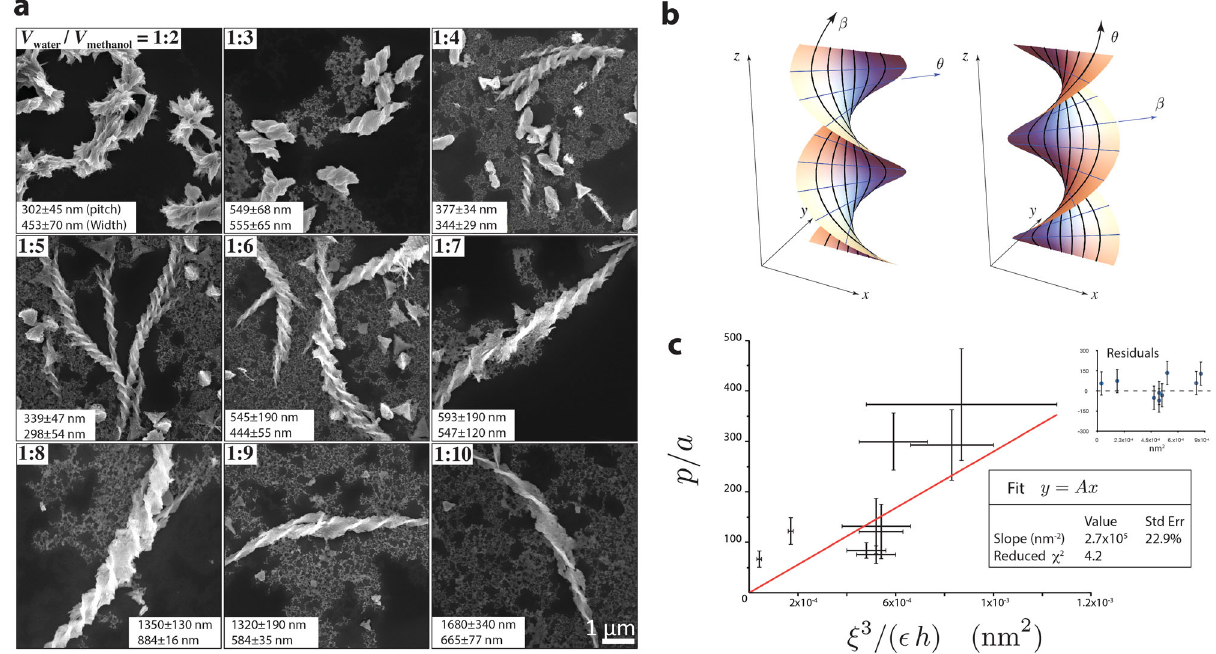
Fig. 3 Comparing morphology of assemblies from experiment and theory. a Experimental observation of helical assemblies of tetrahedral CdTe NPs. b Helicoidal solution for the ribbon ’ s mid-surface obtained from the model. c Linear prediction of the helicoid ’ s pitch on ξ , ϵ , h [Eq. (19)] (red line) fi tted on the experimental data (black data points), where a = 4.5 nm. Error bars show the upper and lower quartiles of the distribution of pitch and thickness of the helices based on each SEM